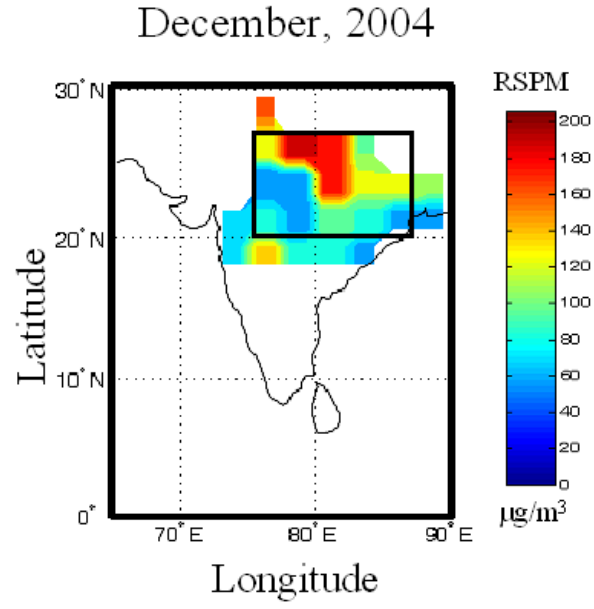
Fig. 10. Mean spatial distribution of RSPM obtained from CPCB over the study domain for December